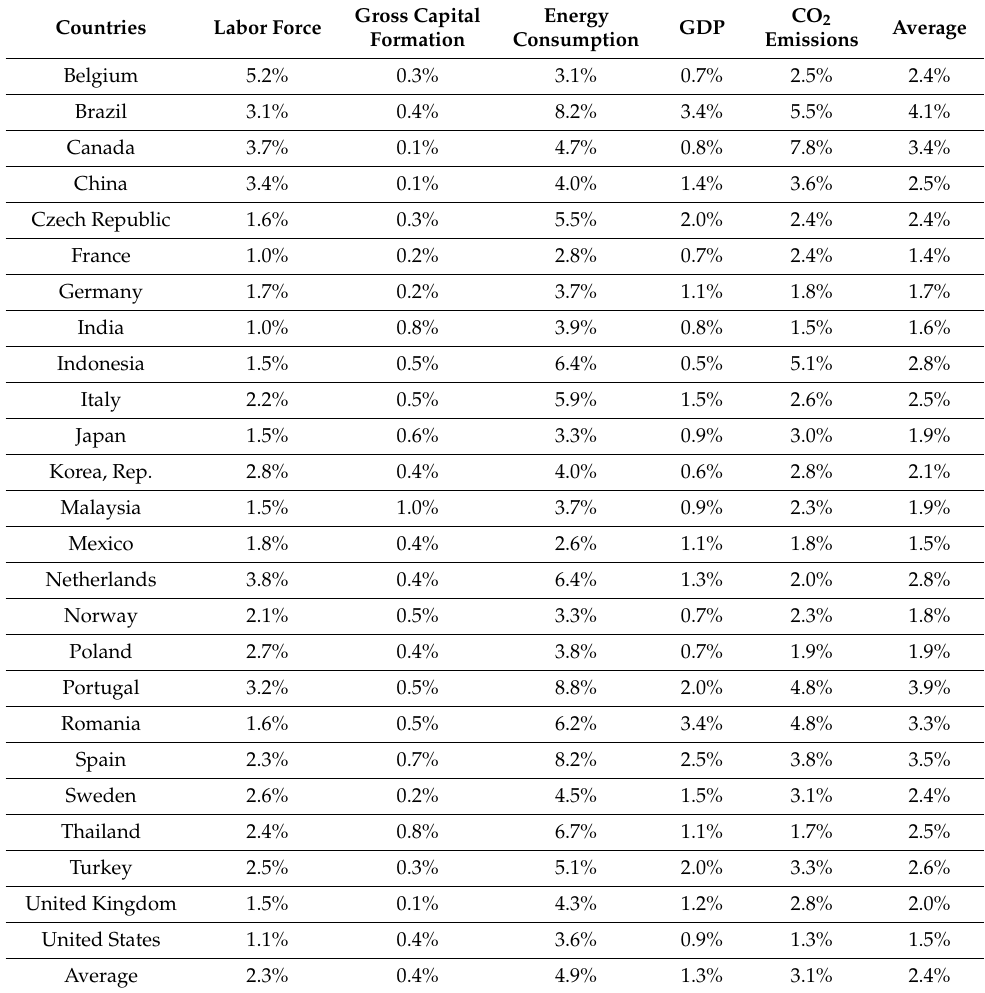
Table 2. Average mean absolute percent error (MAPE) of all